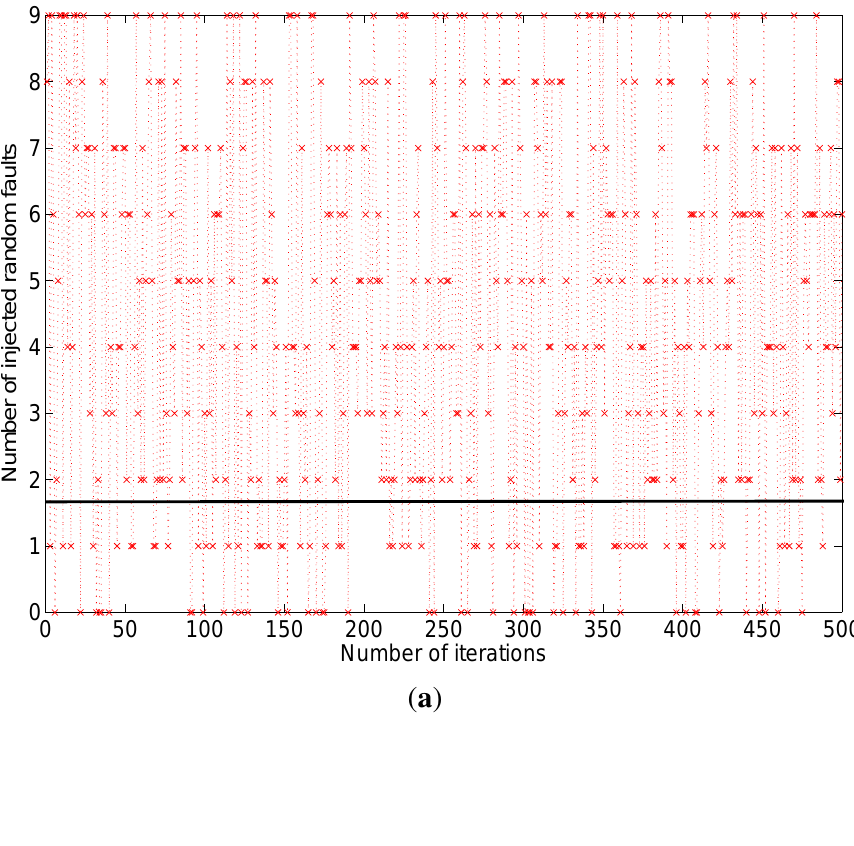
Figure 9. Analysis of the Fault Coverage of the Proposed Radiation Hardened Architecture. ( a ) Fault coverage for 1 bit error with LDPC or Hamming; ( b ) Fault coverage for 3 bit errors; ( c ) Fault coverage for 4 bit errors; ( d ) Fault coverage for 5 bit